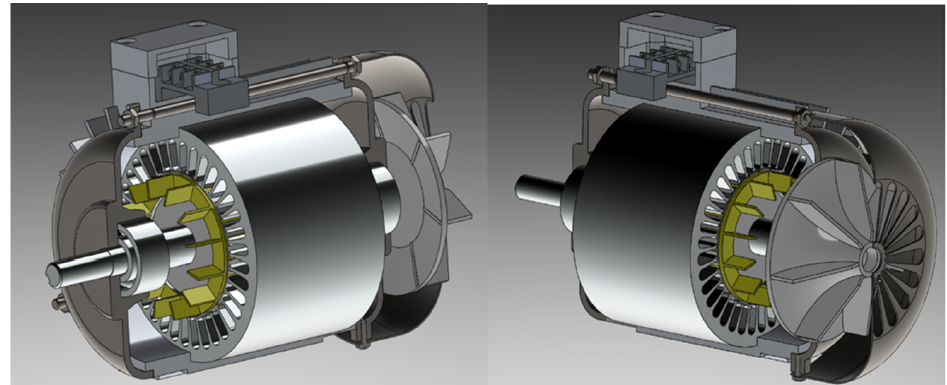
Figure 5. SolidWorks. Induction motor in sectional view.